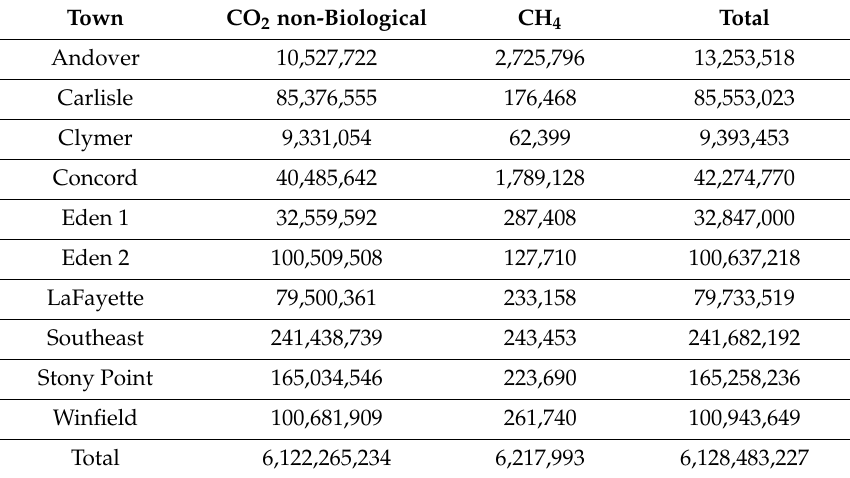
Table 4. USEPA greenhouse gas emissions (Pounds):